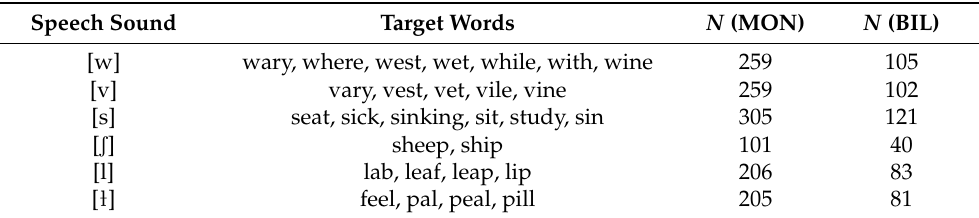
Table 3. Set of non-CS